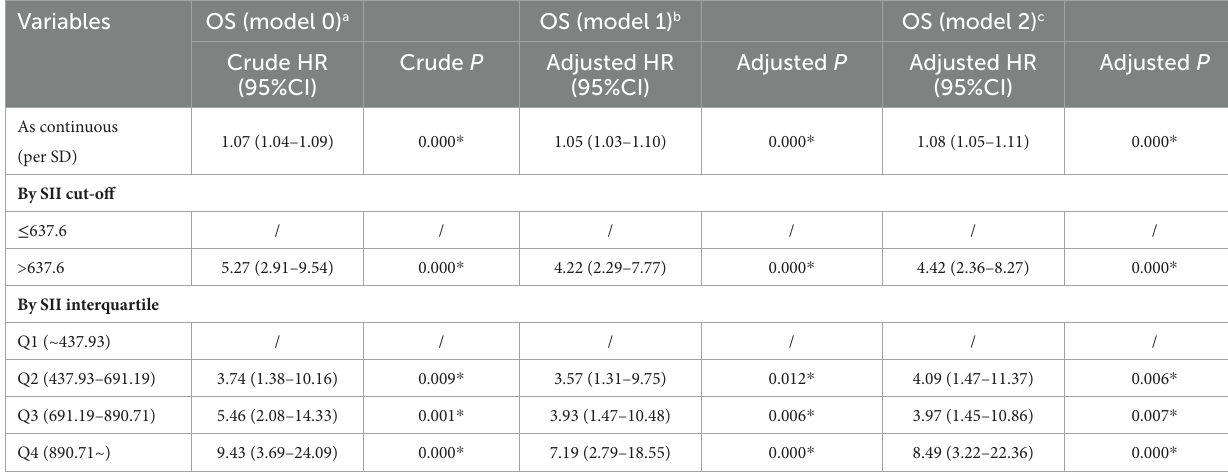
b Model 1: Adjusted for age, gender, BMI and tumor stage. c Model 2: Adjusted for age, gender, BMI, tumor stage, smoking, alcohol, tumor location, differentiated degree, nerve invasion, intravascular tumor emboli, preoperative therapy and postoperative therapy. * p ≤ 0.05.